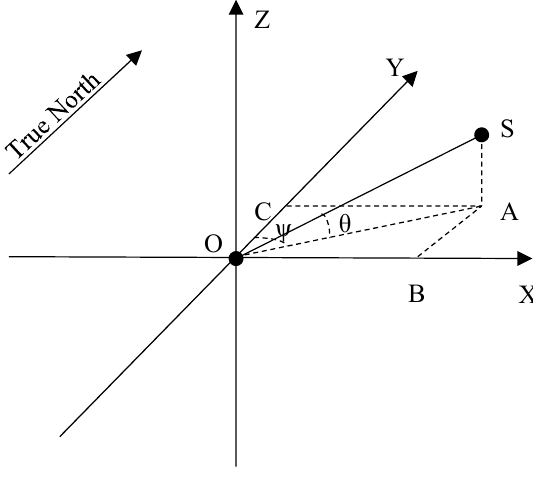
Figure 3. Calculating the viewing zenith and azimuth angles.